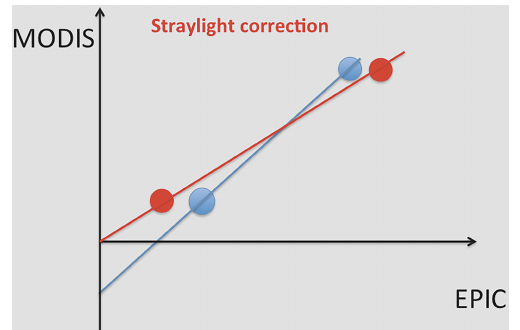
Figure 6. Schematic illustration of the effect of stray light correc- tion. Blue dots and blue line represent a hypothetical regression fit for data without the stray light correction. Red dots and red line are for data with stray light correction. The correction decreases EPIC counts per second values for dark scenes and increases it for bright scenes, thus reducing the slope and the intercept of the fit. See the discussion in the